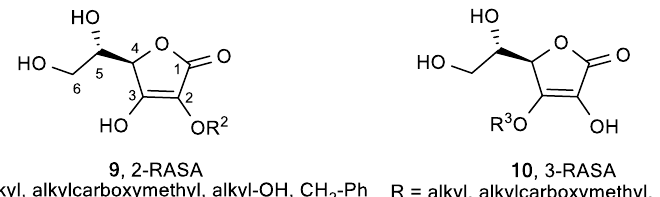
Figure 4. The lipophilic 2- O -alkylated (2-RASA) and 3- O -alkylated (3-RASA) ASA derivatives. Table 1. 1,1-Diphenyl-2-picrylhydrazyl (DPPH) assay, the redox potentials and inhibitory effects on lipid peroxidation in rat liver microsomes of 2-RASA and 3-RASA derivatives. LO Comp.